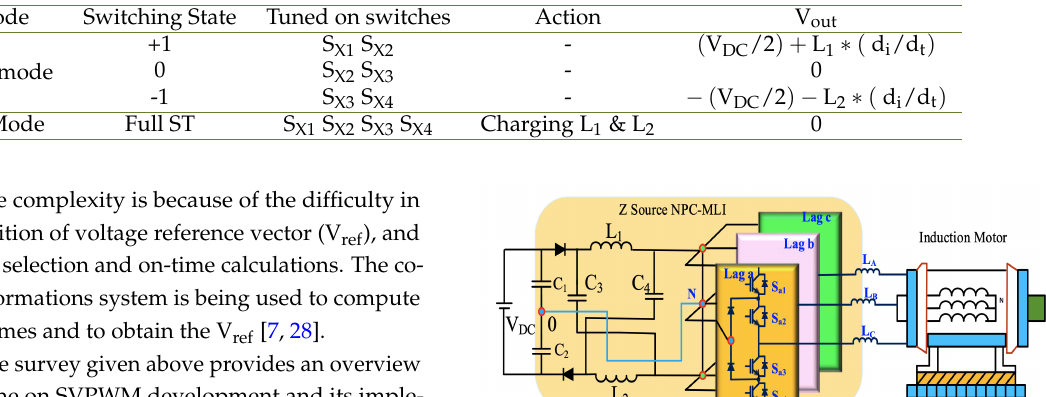
Table 1. Switching table of Z source NPC-MLI with NST and Full ST